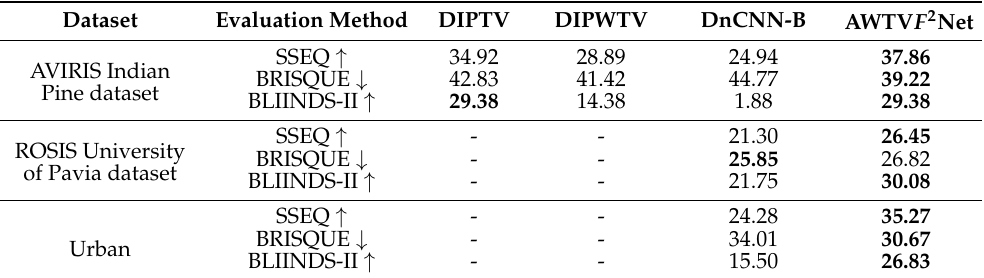
Figure 22. Restored details comparisons of real world noisy remote sensing image datasets. Table 11. Numerical comparisons of different real noisy remote sensing image datasets. The bold values denote the best